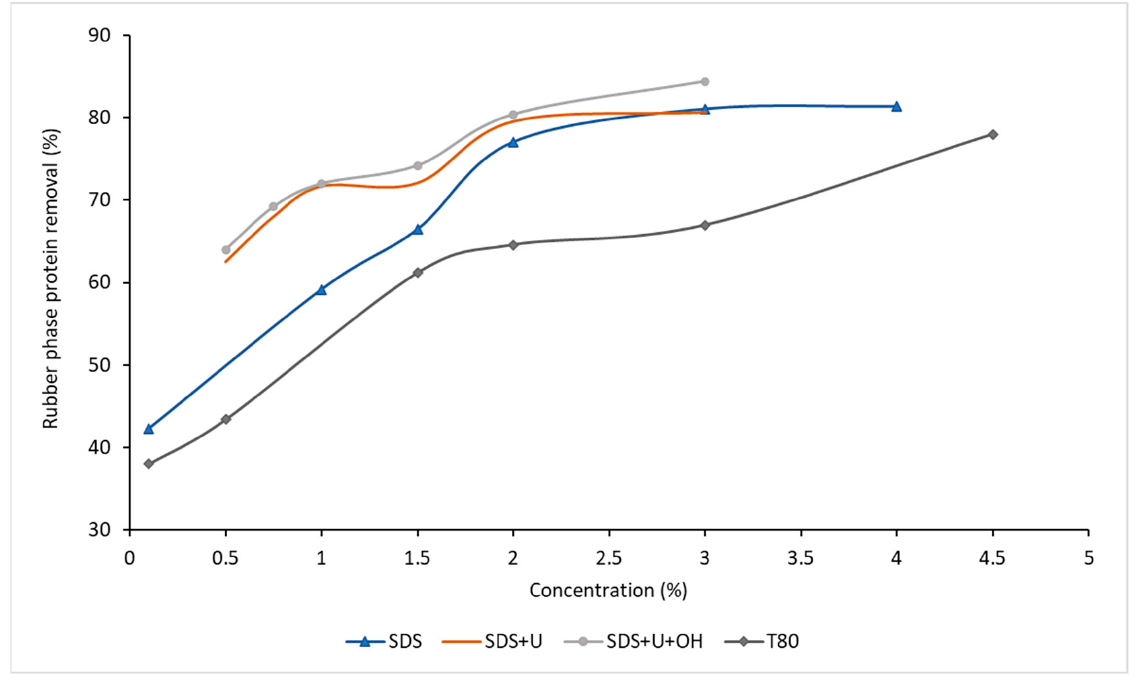
Figure 8. Effect of concentration on the deproteinized systems over protein removal.